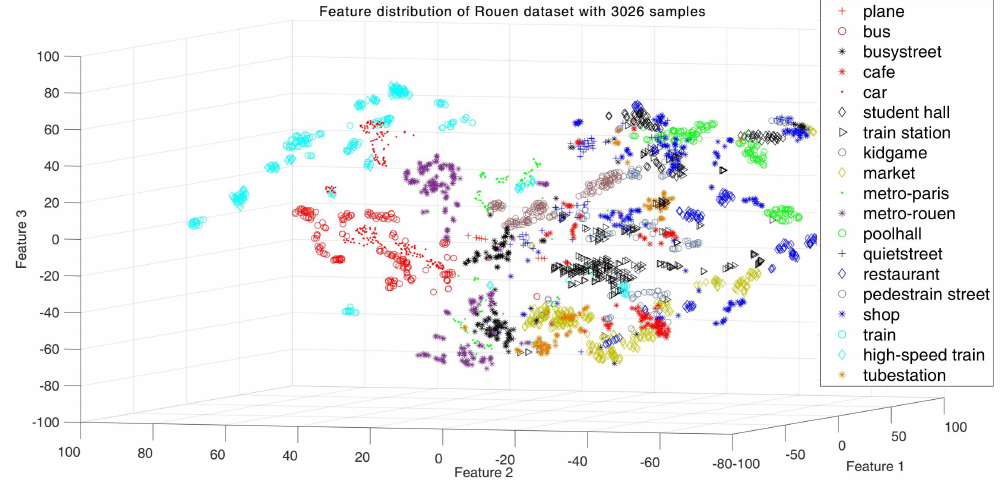
Figure 8. Visualization of Rouen dataset by using CQT+HoG features and t-SNE